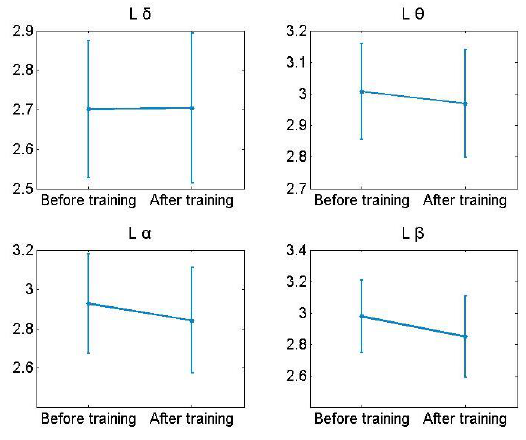
Figure 3. Clustering coefficient of different frequency bands change after training.